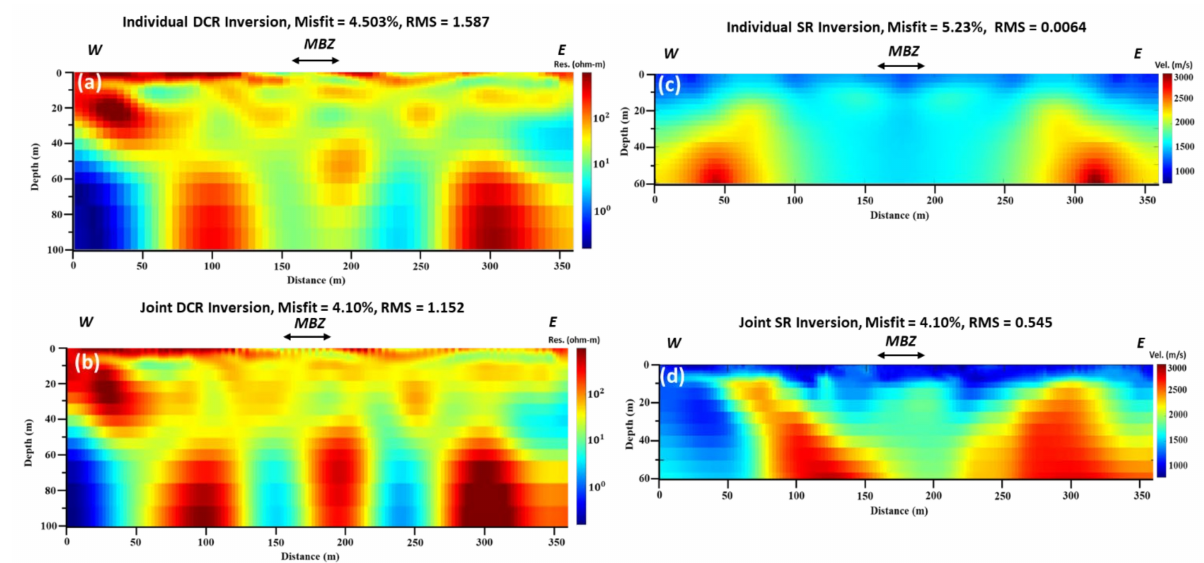
Figure 2. DCR and SR inversion using local optimization method: ( a ) individual inverted resistivity model; ( b ) joint inverted resistivity model; ( c ) individual inverted velocity model; and ( d ) joint inverted velocity model. All geophysical models are vertically exaggerated by 1.35.